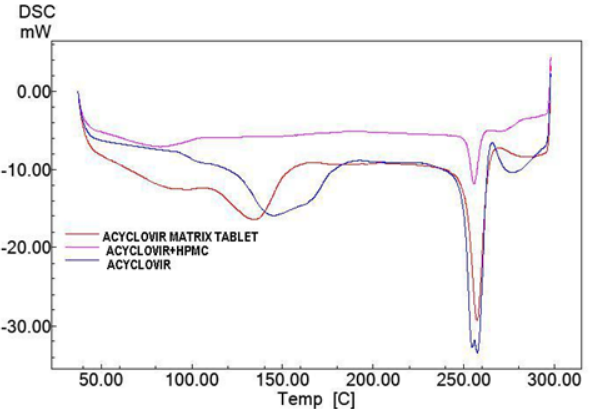
Figure 1. DSC thermograms of acyclovir, polymer, and acyclovir matrix.